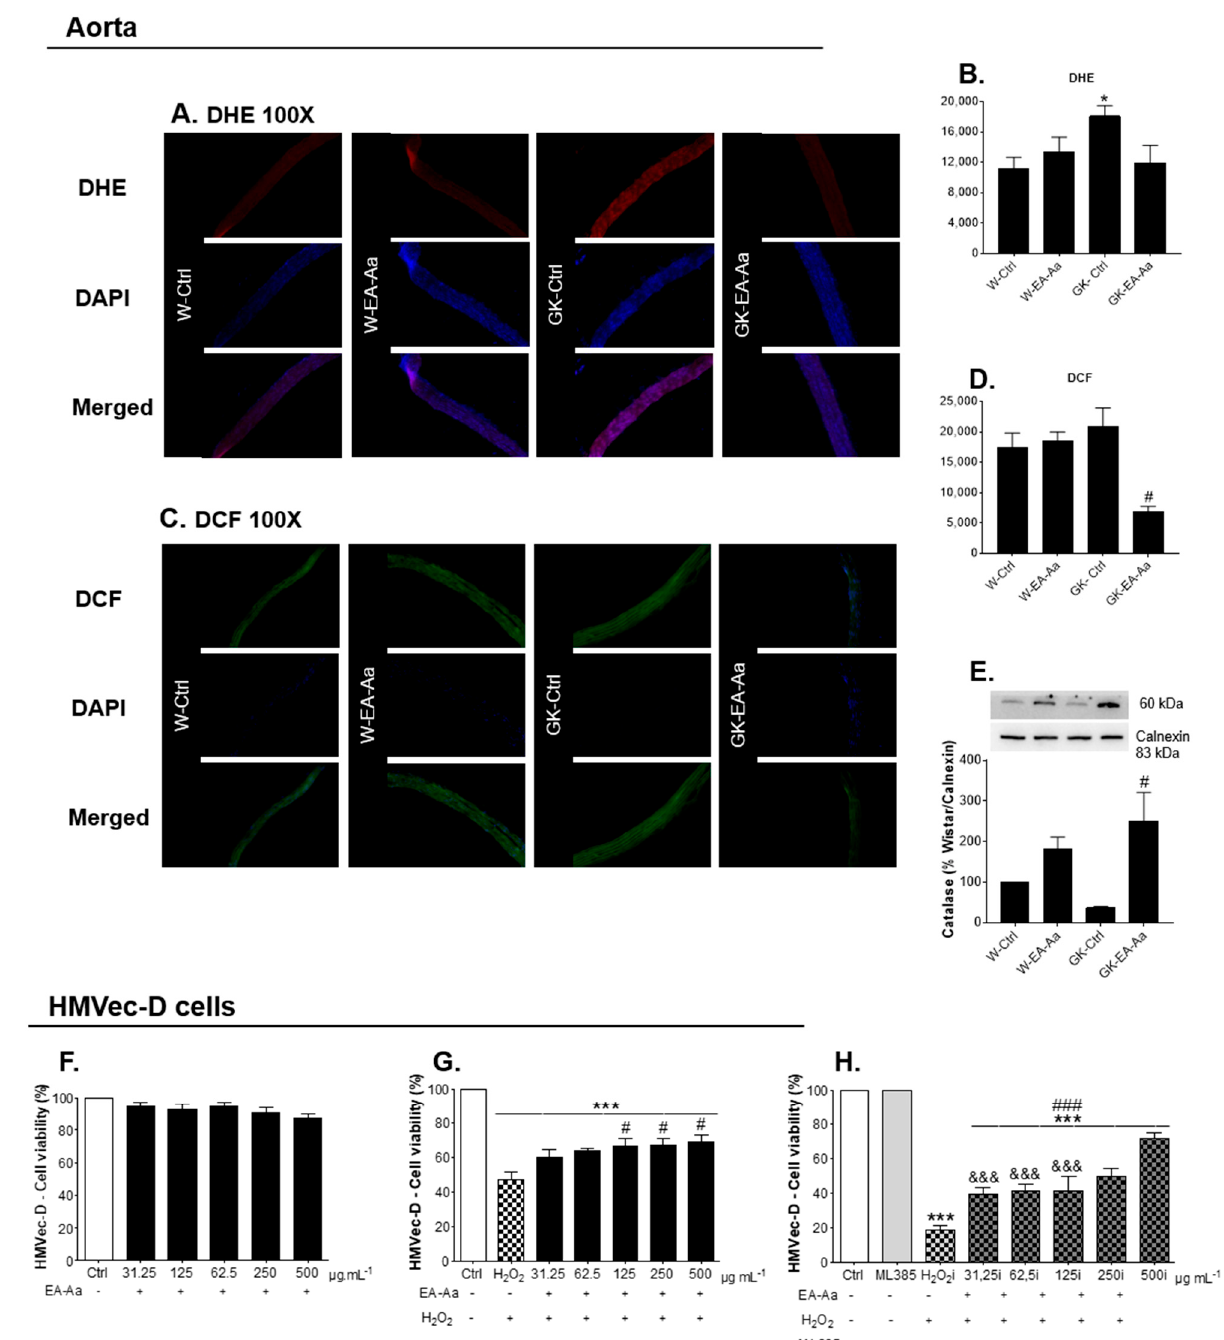
Figure 6. Antioxidant protection of EA-Aa at the vascular level, in aorta and in human endothelial microvascular dermal cells (HMVec-D). ( A ) DHE staining in aorta. ( B ) Fluorescence intensity of DHE; staining in aorta shows a restoration in intensity of fluorescence in GK-EA-Aa group in relation to GK-Ctrl. ( C ) DCF staining in aorta. ( D ) Fluorescence intensity of DCF; staining in aorta shows a reduction after the treatment with EA-Aa ( n = 5). ( E ) Catalase levels in aorta; treatment with EA-Aa increases catalase levels in GK-EA-Aa ( n = 5). Cell viability of HMVec-D cells ( n = 3 independent experiments): ( F ) Treatment with EA-Aa for 24 h. ( G ) Previous treatment with EA-Aa (for 30 min) and induction to oxidative stress with H 2 O 2 (for 2 h).; a protection of EA-Aa against H 2 O 2 is evidenced since 125 µ g.mL − 1 . ( H ) Pre-treatment of cells with NRF2 inhibitor, ML385, followed by incubation with EA-Aa and induction with H 2 O 2 ; EA-Aa increases cell metabolic function in all concentrations and presents differences in relation to the non-inhibited group in 31.25–125 µ g.mL − 1 . * vs. W-Ctrl/Ctrl; # vs. GK-Ctrl/ H 2 O 2 ; & vs. same point without NRF2 inhibitor; *,# p < 0.05, ***,###,&&& p <